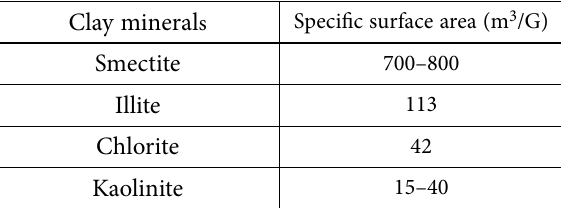
Table 1. Specific surface area of various clay minerals Clay mineral